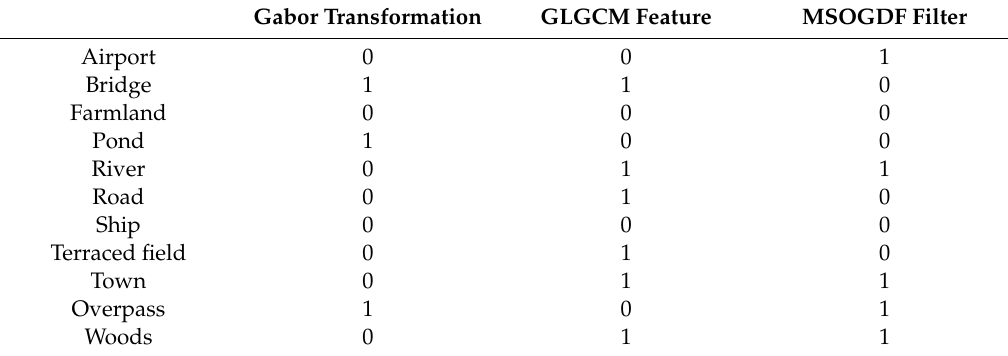
Table 4. Feature selection.